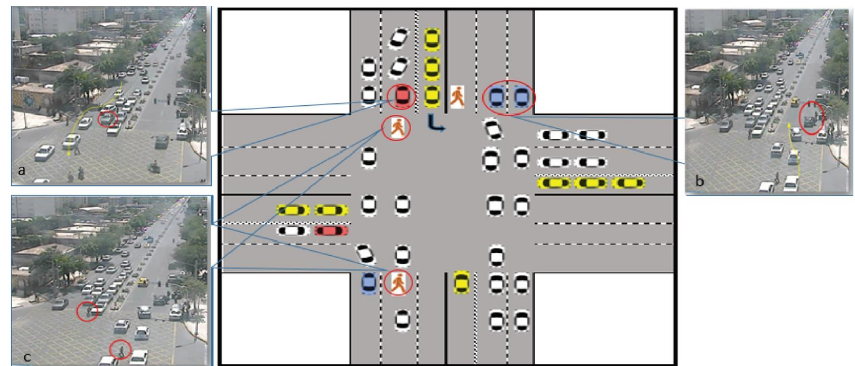
Figure 2: Trafc violations at intersections: (a) OTL, (b) SNI, and (c) JSC.